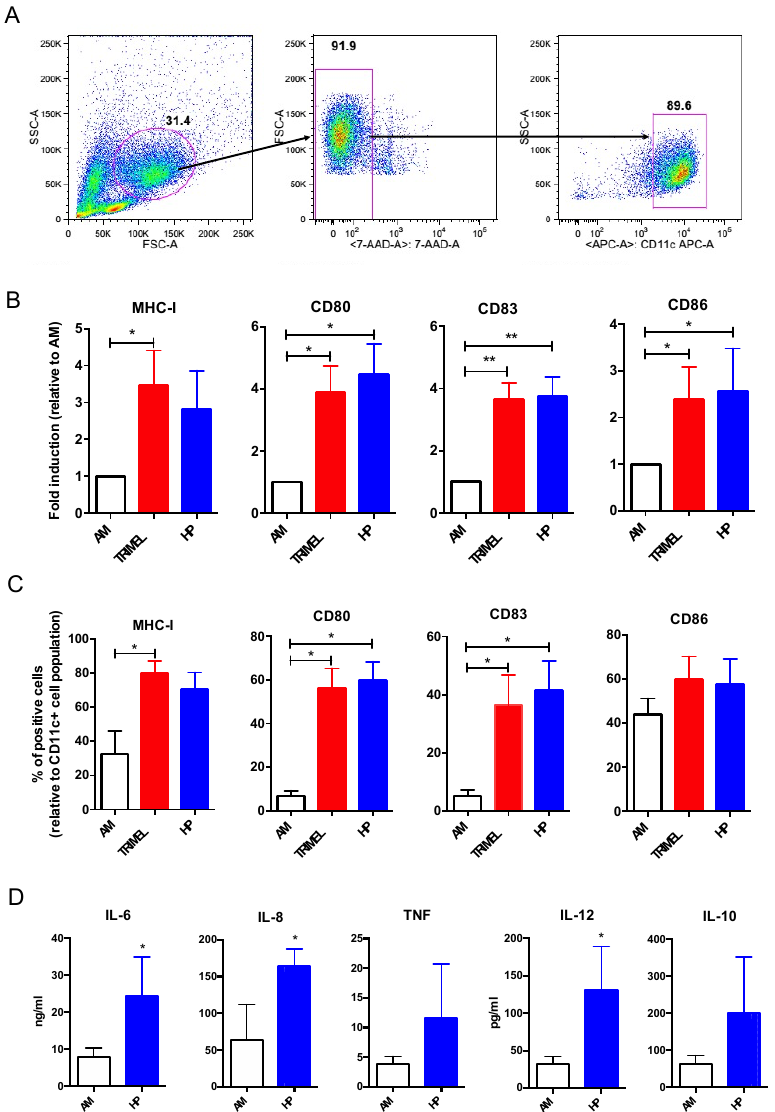
Figure 3. In vitro effects of HP on primary human monocyte-derived iDCs phenotype and cytokine production. DC lineage was induced with IL-4 (500 U/mL), and GM-CSF (800 U/mL) as previously described [18], before additional stimulation with HP and HS-MCL (TRIMEL) lysate as control. ( A ) gating strategy; ( B ) MHC-I, CD80, CD83 and CD86 expression in unstimulated cells (AM), TRIMEL-stimulated cells (50 μ g/mL), and HP-stimulated cells (10 ng/mL); ( C ) percentage of MHC-I, CD80, CD83, and CD86 positive cells in AM, TRIMEL-stimulated cells (50 μ g/mL), and HP-stimulated cells (0,1 and 10 ng/mL); ( D ) IL-12, TNF- α , IL-10, IL-6, and IL-8 secretion. The concentration of cytokines was analyzed in supernatants obtained from 24 h co-cultures of AM or HP-stimulated iDCs with CD-40L expressing fibroblast (1:1 ratio). * p < 0.05; ** p < 0.01 .